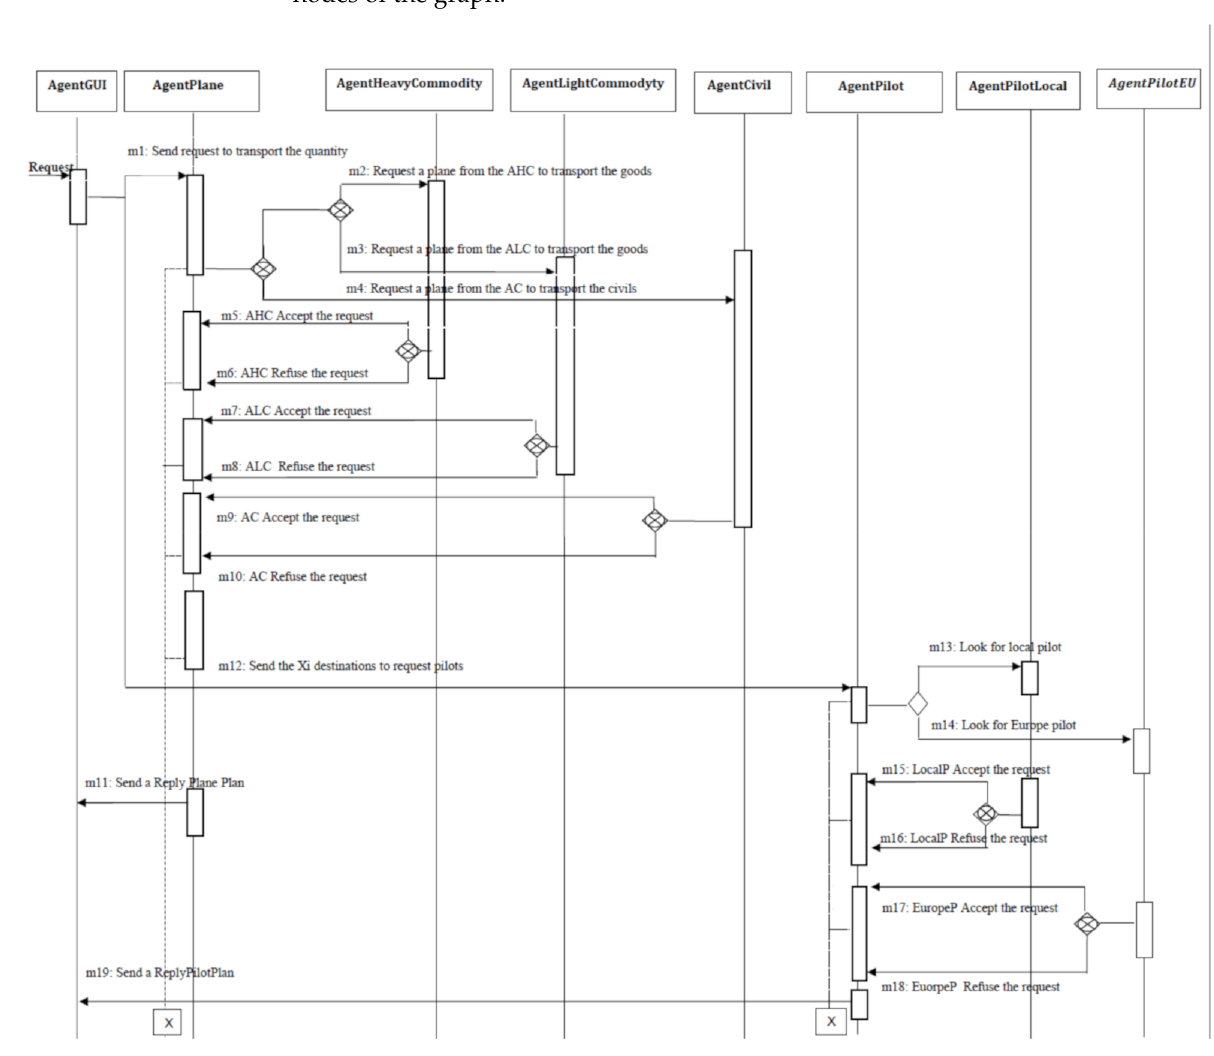
Figure 4. Sequence